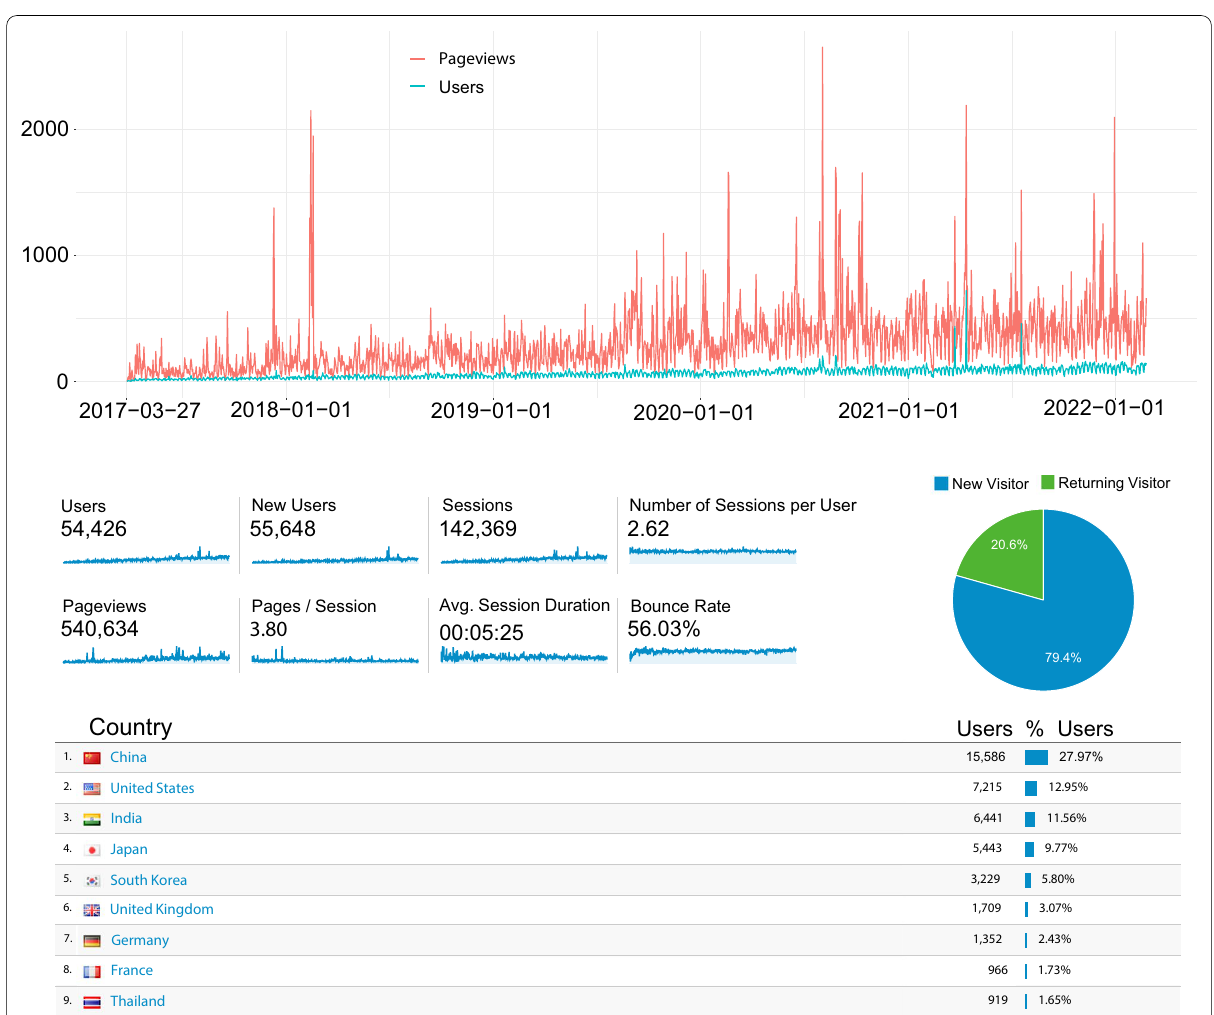
Fig. 1 Statistics of the funRiceGenes database visits reported by Google Analytics. The top panel displays the daily user visits and pageviews of the funRiceGenes database from Mar 27 2017 to Feb 24 2022. The middle panel lists the total user visits, pageviews, and other statistics in the last 5 years. The bottom panel shows the proportion of user visits from different countries in the last 5